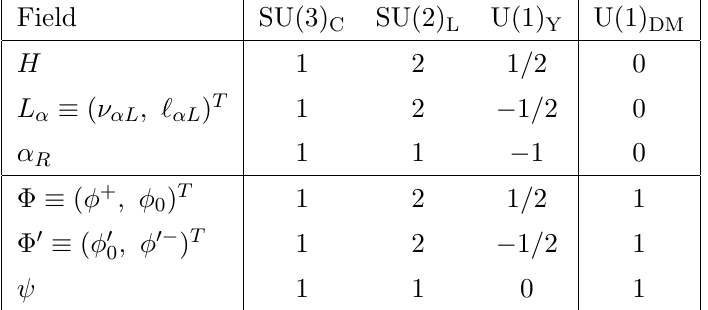
Table 1 . Particle content and quantum numbers of the GScM. The upper block corresponds to the SM Higgs doublet and the SM leptons, with (cid:13)avour index (cid:11) = e; (cid:22); (cid:28) . The lower part shows the dark sector of the model: two scalar doublets (cid:8) and (cid:8) 0 , and one Dirac fermion . In the